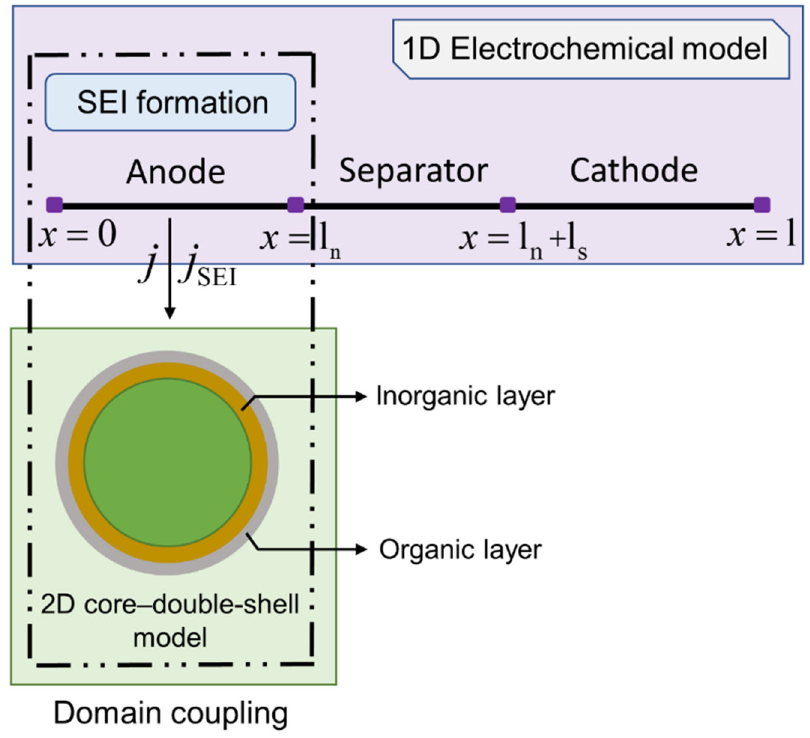
Figure 1. Simulation model showing the coupling between the 1D electrochemical model and the 2D core–double-shell